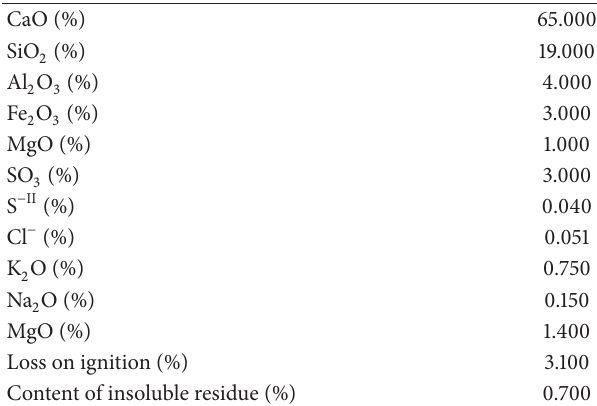
Table 2: OPC’s chemical composition [17].